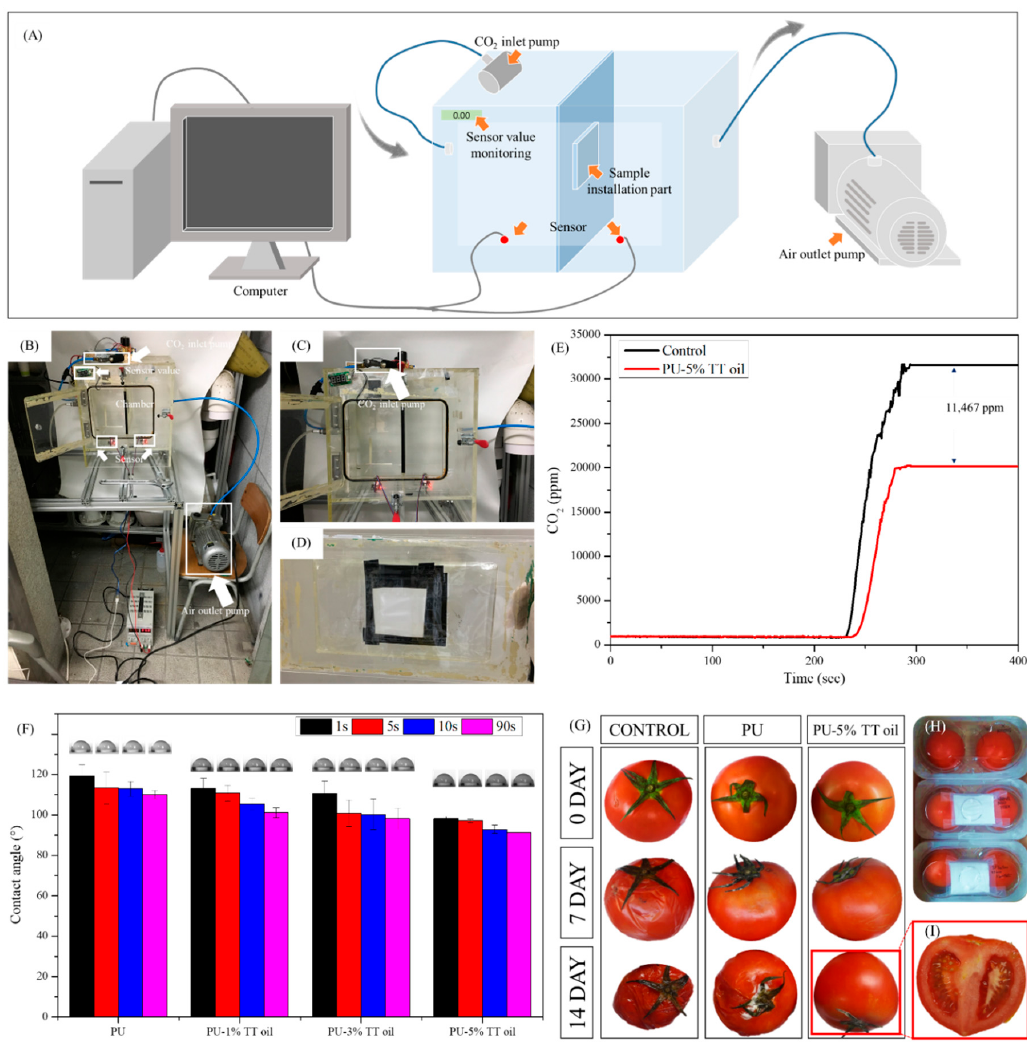
Figure 4. ( A ) Schematic of the CO 2 concentration testing hand-made apparatus set-up. ( B – D ) Set-up of the hand-made apparatus for comparing the concentration of CO 2 . ( E ) The graph of the CO 2